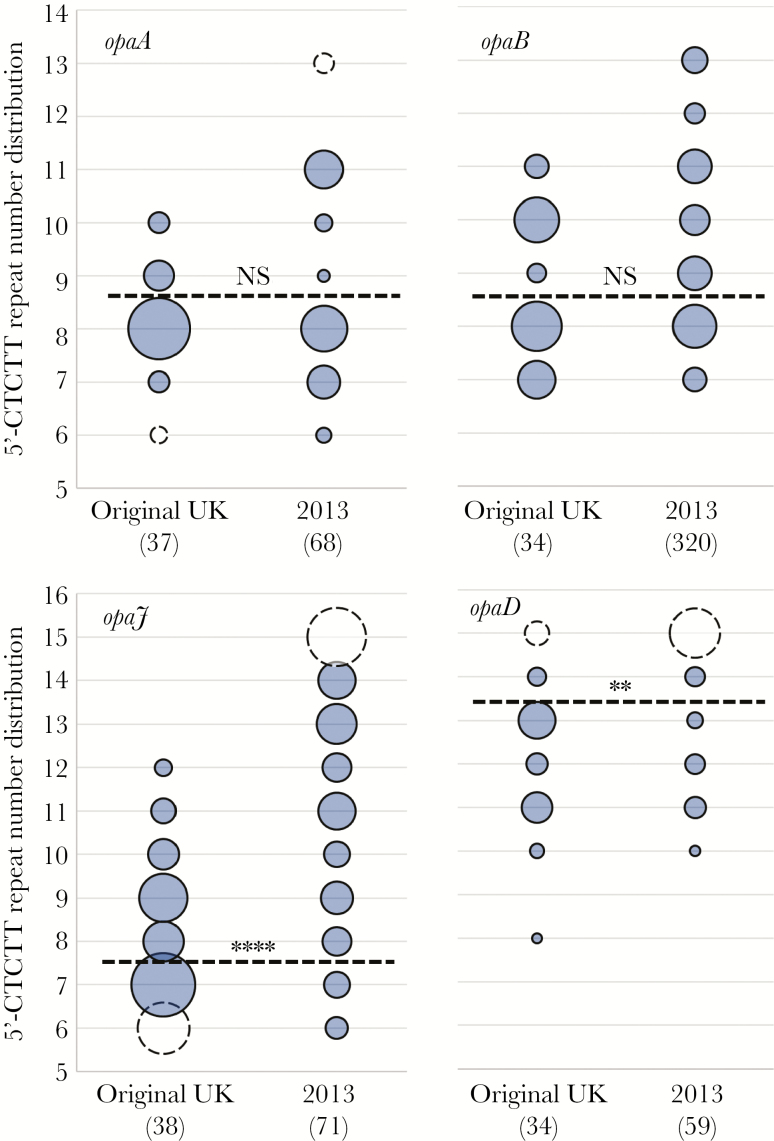
Increases in repeat number for the 4 phase-variable opa genes between the Neisseria meningitidis serogroup W (MenW) clonal complex 11 original UK and 2013 strains. Repeat numbers were determined for the 4 opa loci by polymerase chain reaction fragment analysis of genomic DNA extracts for multiple disease isolates of the original UK and 2013 strains of the MenW ST-11 South American strain lineage (total numbers of isolates of each type are shown in parentheses). The bubbles and dashed lines are as described for Figure 1. NS, not significant. **P ≤ .01 and ****P ≤ .0001.